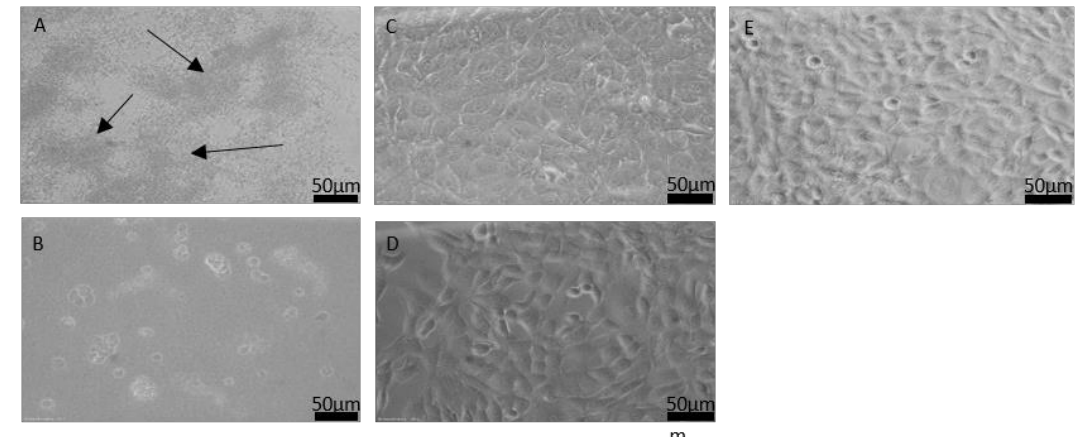
Figure 4. Light microscopic images of cell growth after 48 h incubation in media conditioned with ( A ) galinstan-silicone rubber, ( B ) silicone rubber sample sterilized for 90 min using UV light, ( C ) galinstan-silicone rubber, and ( D ) silicone rubber sterilized using steam sterilization. ( E ) Cells without sample, grown under normal cell-culture conditions. ( A ) The arrows show the bacteria clouds; ( B ) reduced cell growth and necrotic cells on a layer of bacteria; ( C – E ) a confluent layer of fibroblast cells.